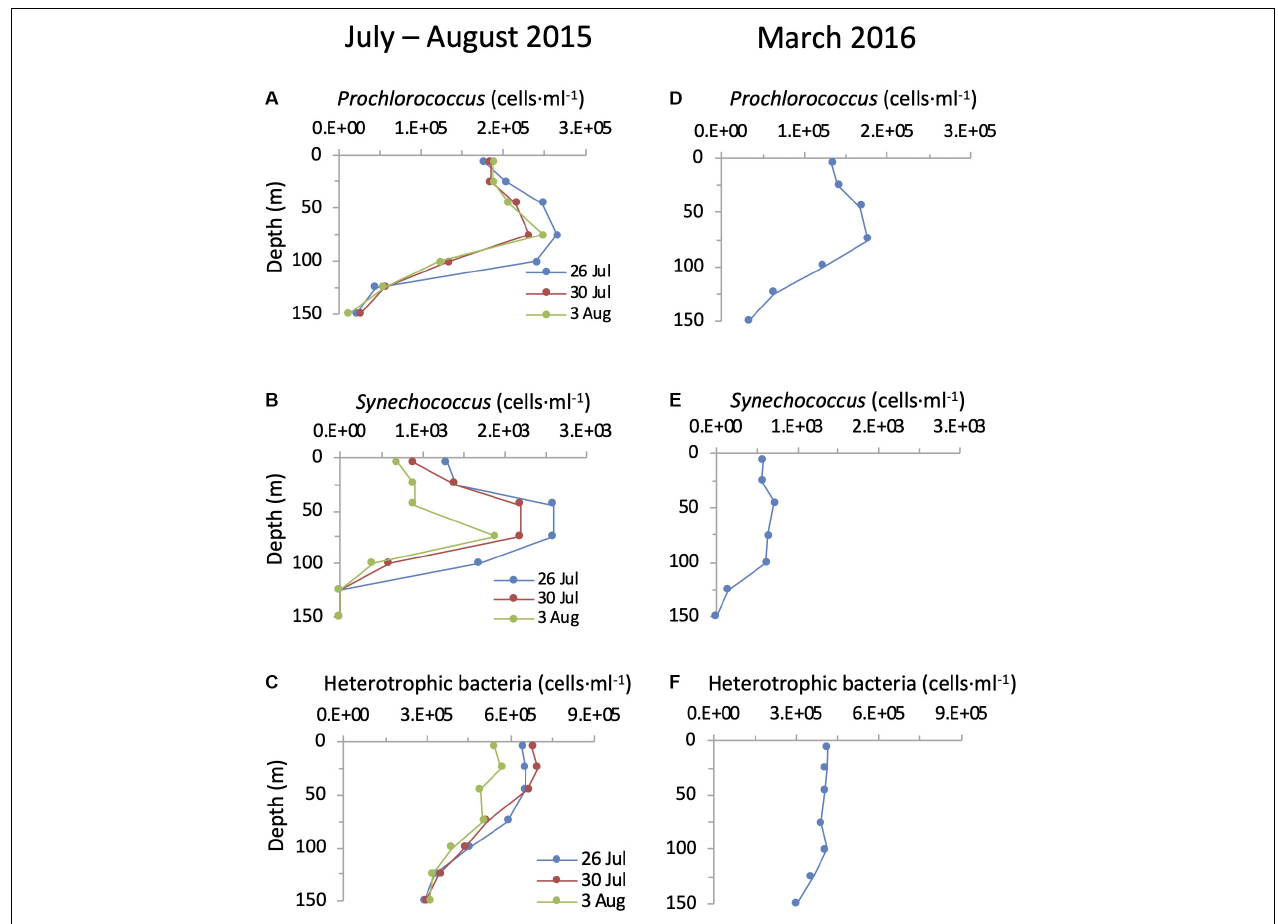
FIGURE 5 | Depth distribution of cyanobacteria and heterotrophic bacteria in the NPSG. Abundances of Prochlorococcus (A,D) , Synechococcus (B,E) and heterotrophic bacteria (C,F) during the summer cruise in July–August 2015 (left panels) and in the spring cruise in March 2016 (right panels).